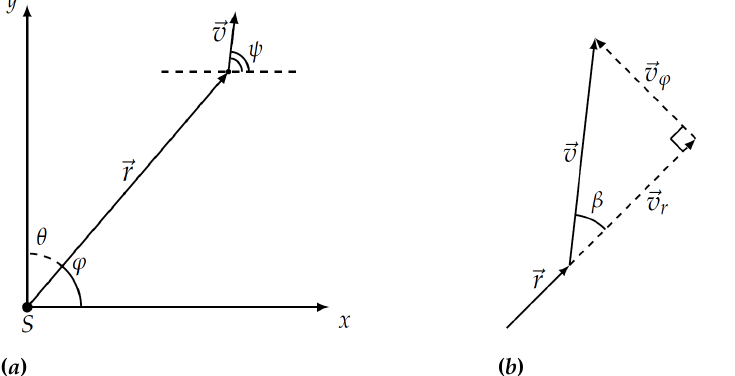
Figure 1. The mobile vehicle in the Cartesian plane with sensor S ( a ) and its velocity vectors (cid:126) v , (cid:126) v r and (cid:126) v ϕ ( b ).